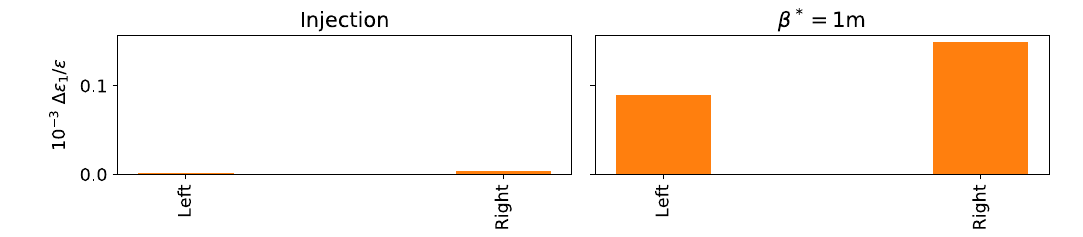
FIG. 8. Relative emittance growth produced by one-turn flux jumps causing a reaction of the regulation loop of the main circuit of each triplet at injection (left) and 1 m optics (right) optics, causing a relative strength change of 0 . 1 × 10 − 4 . It should be noted how this effect is significantly smaller than that produced by the flux jump in the field